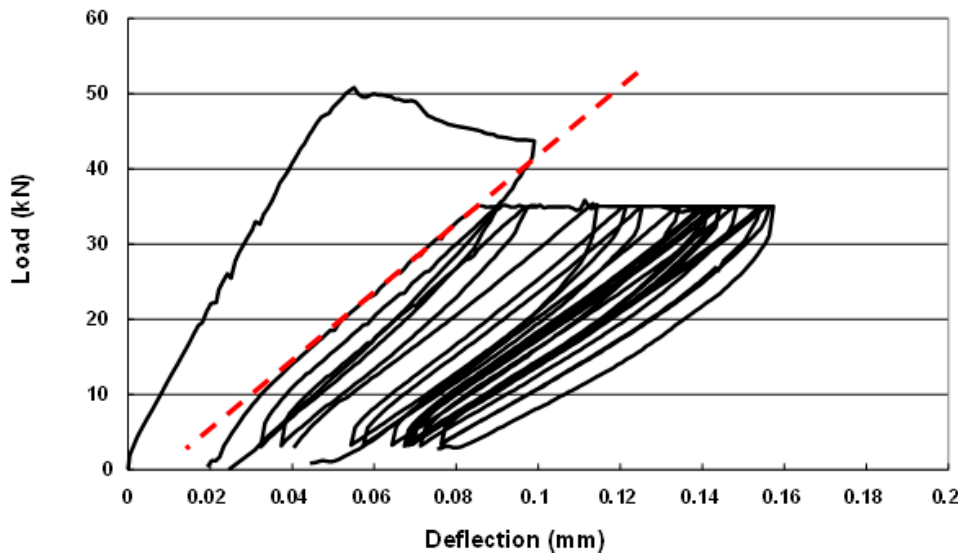
Figure 2. Example of unloading/reloading cycle procedure during sustained loading.